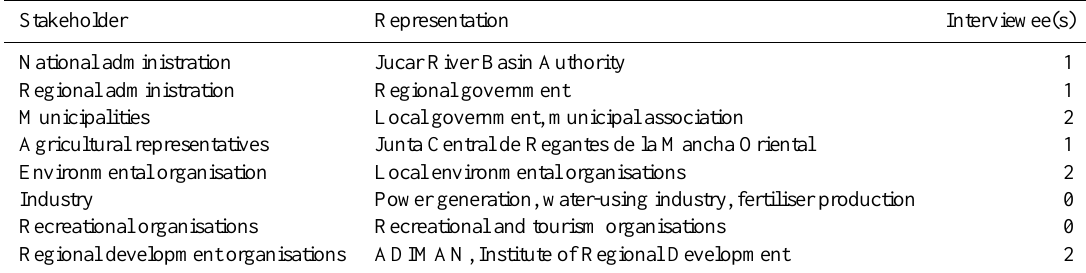
Table 1. Stakeholder groups and representatives in La Mancha Oriental.